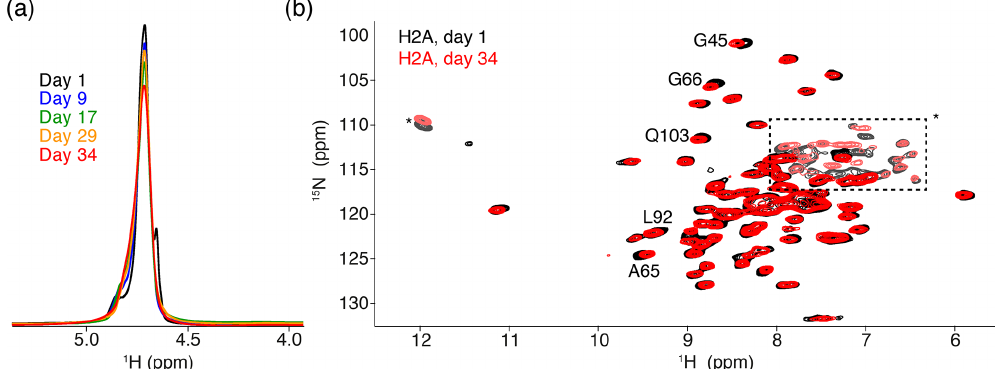
Figure 2. Comparison of NMR data recorded directly after sedimentation and after 5 months. (a) Overlay of the 1D one-pulse 1 H spectrum showing the highly dominant water signal. Spectra are annotated with the cumulative number of days of ssNMR measurements (total of 34d). The sample was stored in between measurement sessions at 4 ◦ C. (b) Overlay of the 2D 1 H-detected CP-based NH correlation spectrum acquired at the beginning and end of the NMR measurements. Resonances with slight chemical shift changes are indicated. Resonances with light color, indicated by an * or in the dashed box, are from side-chain resonances. Some of these side-chain resonances are folded into a different position along the 15 N dimension due to use of a different offset frequency. Color coding for both panels indicated in the